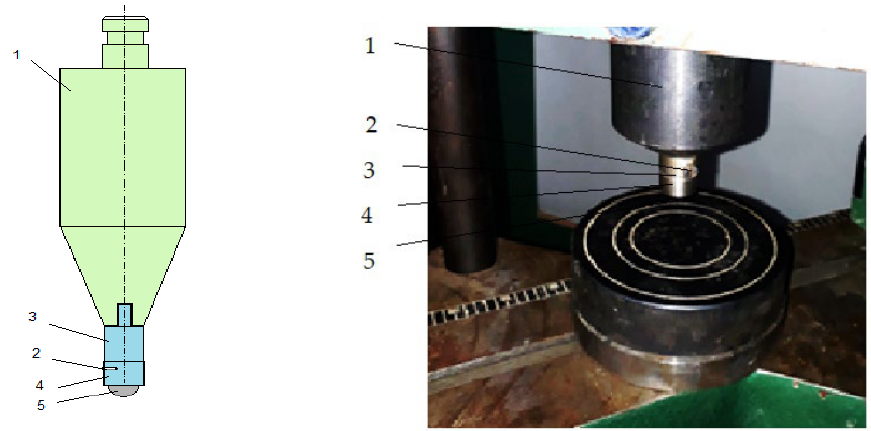
Figure 7. Brinell hardness tester: 1—device body; 2—threaded pin; 3—additional punch; 4—bushing; 5—metal ball.